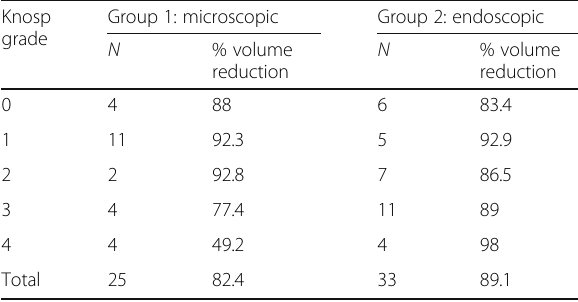
Table 1 Percentage of volume reduction according to Knosp grade in each group Knosp